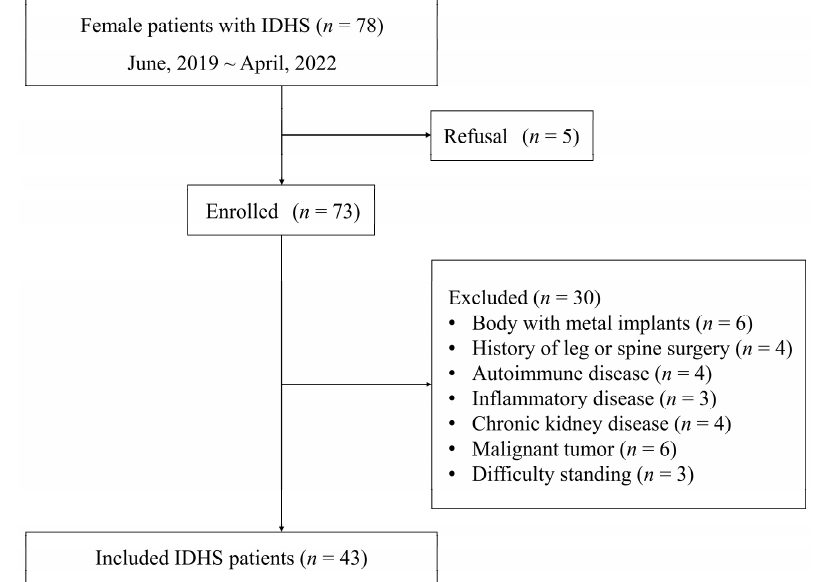
Figure 1. Flowchart of patient selection.